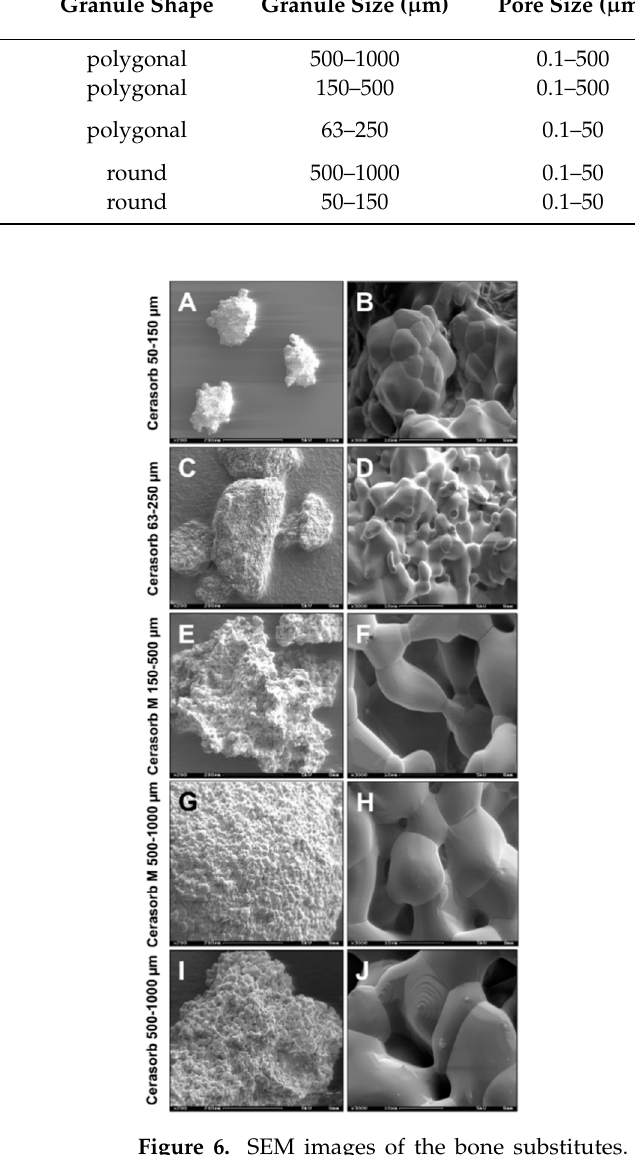
Figure 6. SEM images of the bone substitutes. The images show the various bone materials: ( A , B